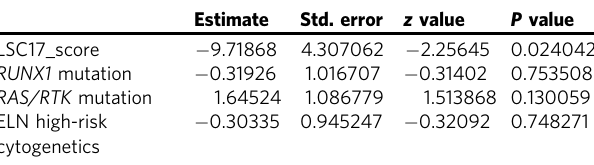
Table 2 Multi-logistic regression analysis against CR by considering following variables: LSC17 score (as a continuous variable), RUNX1 mutation status (mutated vs. wild type), RAS-RTK mutation status (mutated vs. wild type), and ELN high-risk cytogenetics classi fi cation (high risk vs.